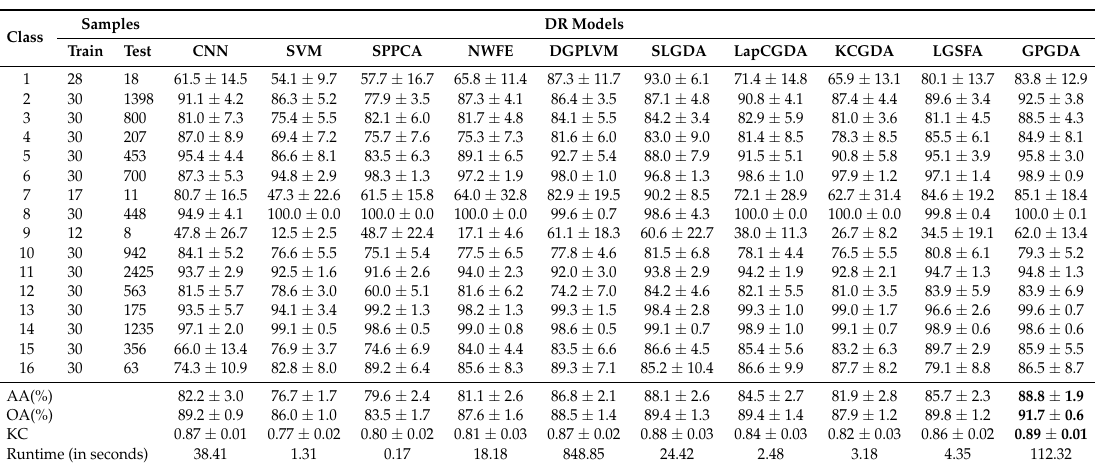
Table 4. Classification results of CNN and different dimensionality reduction methods based on SVM on the Indian Pines